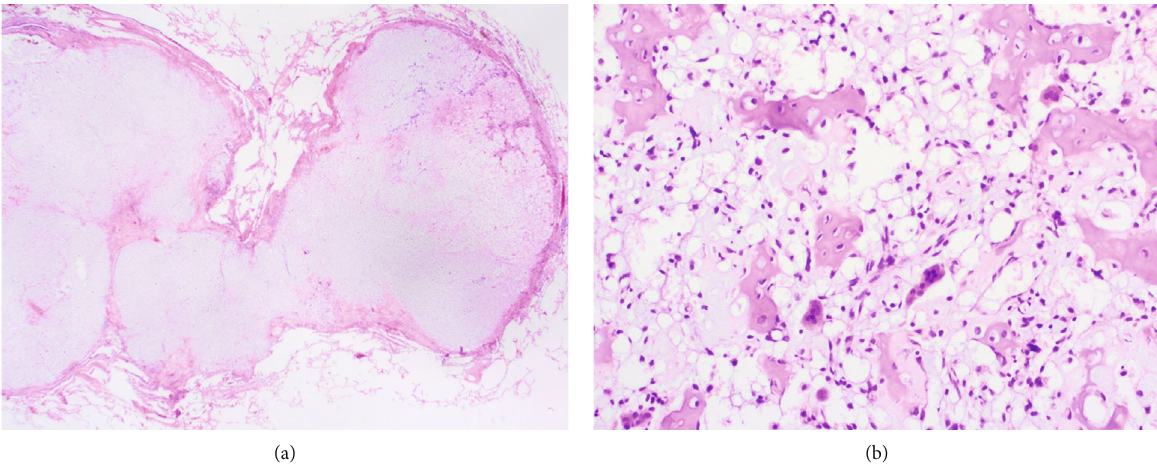
Figure 1: Histopathological image of the primary tumor. Atypical rounded cells with abundant clear cytoplasm, arranged in lobules, and admixed with trabeculae of woven bone and osteoclast-like giant cells (hematoxylin and eosin, original magni fi cation (a) 100x and (b)